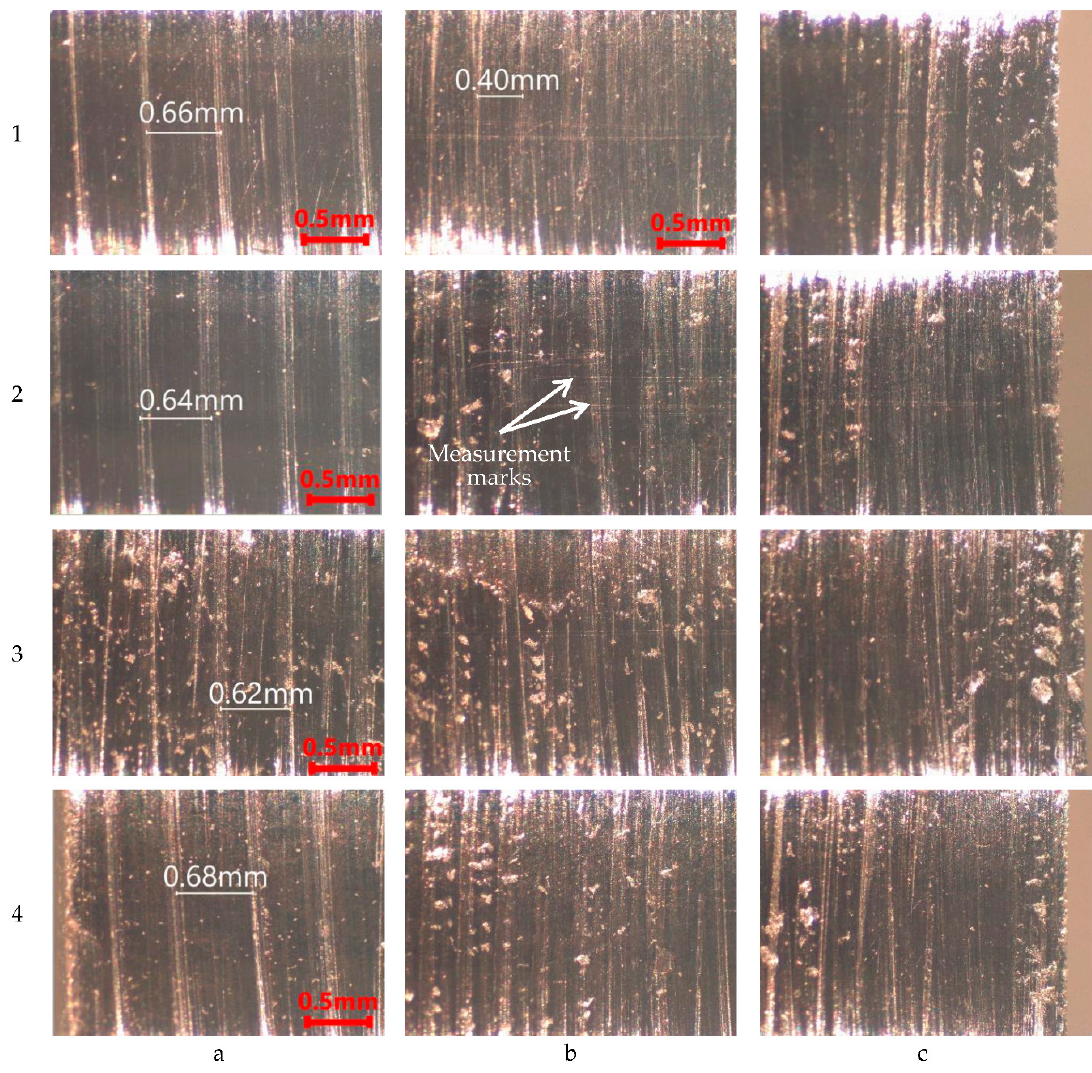
Figure 10. Microscopic images of the sectioned holes taken at different depths from the top surface of the hole: ( a ) bottom zone, ( b ) middle zone and ( c ) top zone.